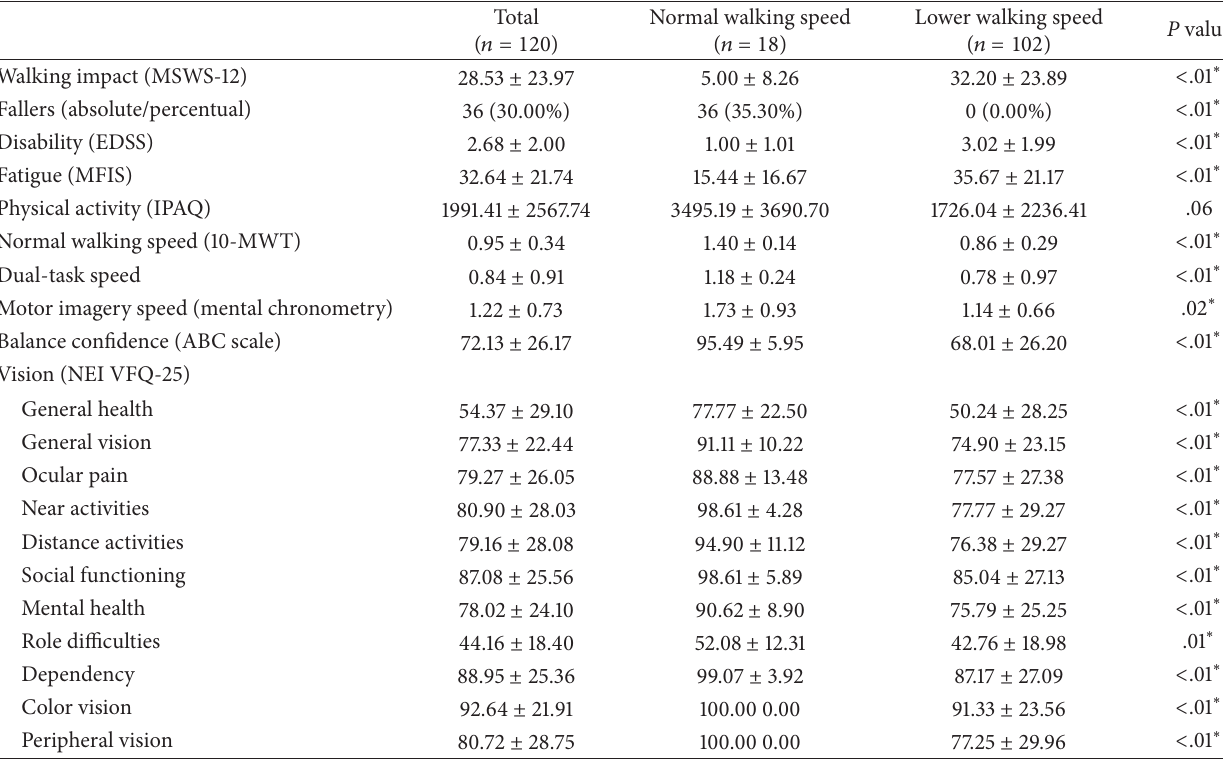
Table 1: Clinical characteristics of 120 persons with multiple sclerosis.